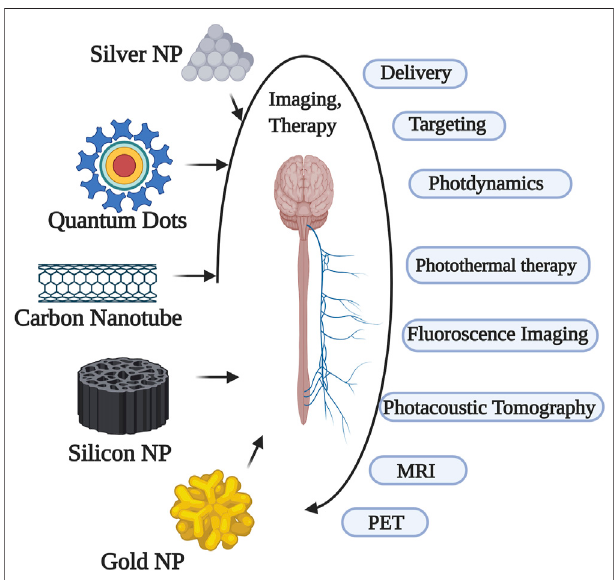
FIGURE 2 | Various nanoparticles and their applications in nervous